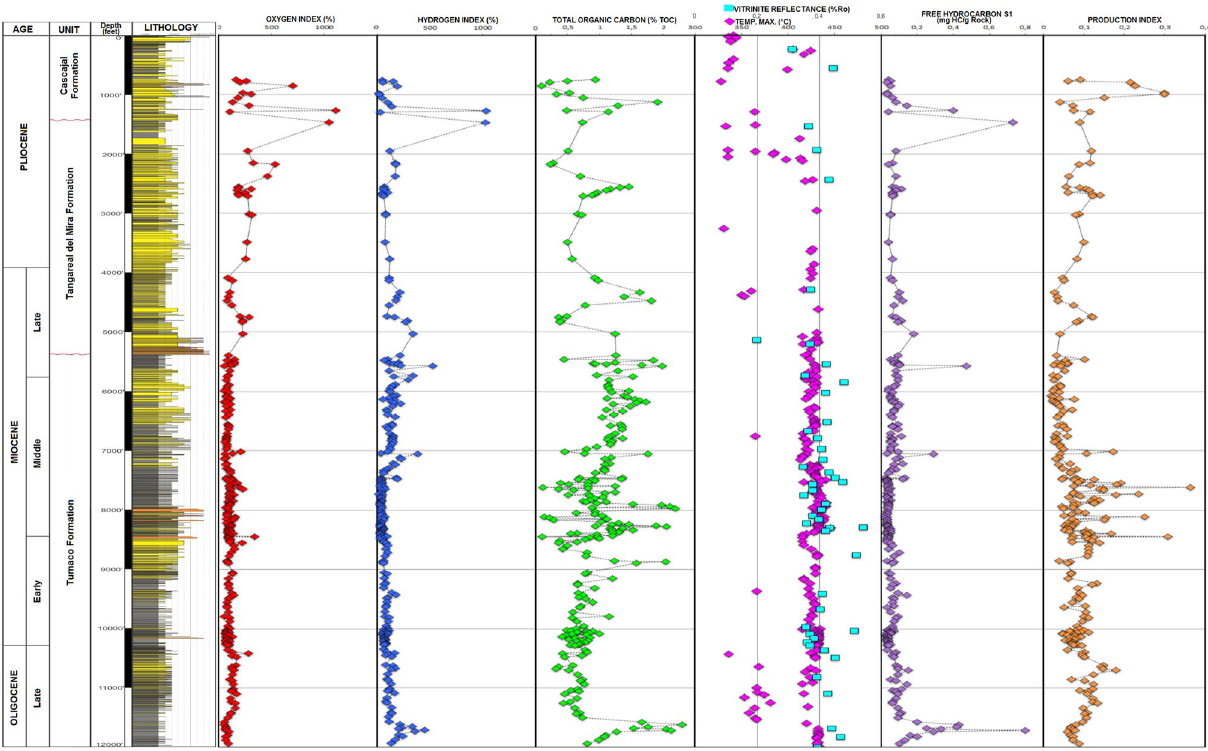
Fig. 9 Idealized geochemical logging based on RE-pyrolysis indexes, TOC and Ro for Tumaco-ST-P, Tumaco basin, Colombia (modified